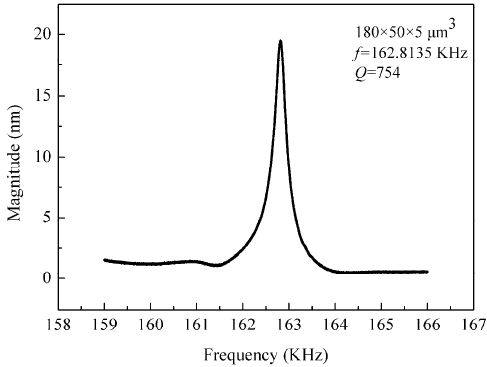
Figure 2. Resonance spectrum of cantilever measured in air.